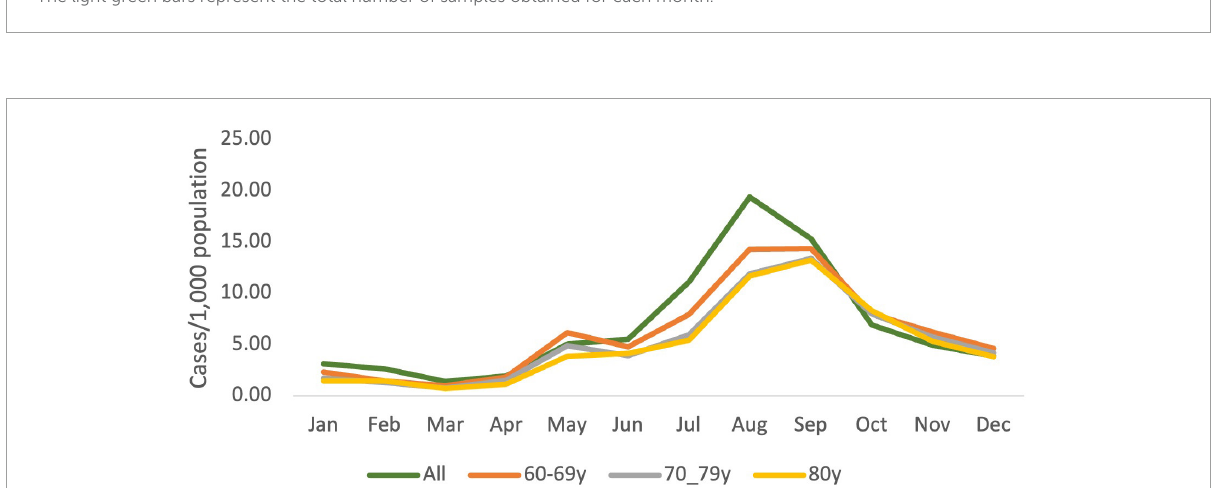
FIGURE3 Monthly newly detected cases of COVID-19 in Malaysia for the total population and by age groups for 2021. Total numbers of new cases and the number of new cases for all ages (green) and individuals within the age groups of 60–69 (orange), 70-79 (gray) and 80 (yellow) years reported in Malaysia per 1,000 population each month in 2021. Data obtained from https://github.com/MoH-Malaysia/covid19-public